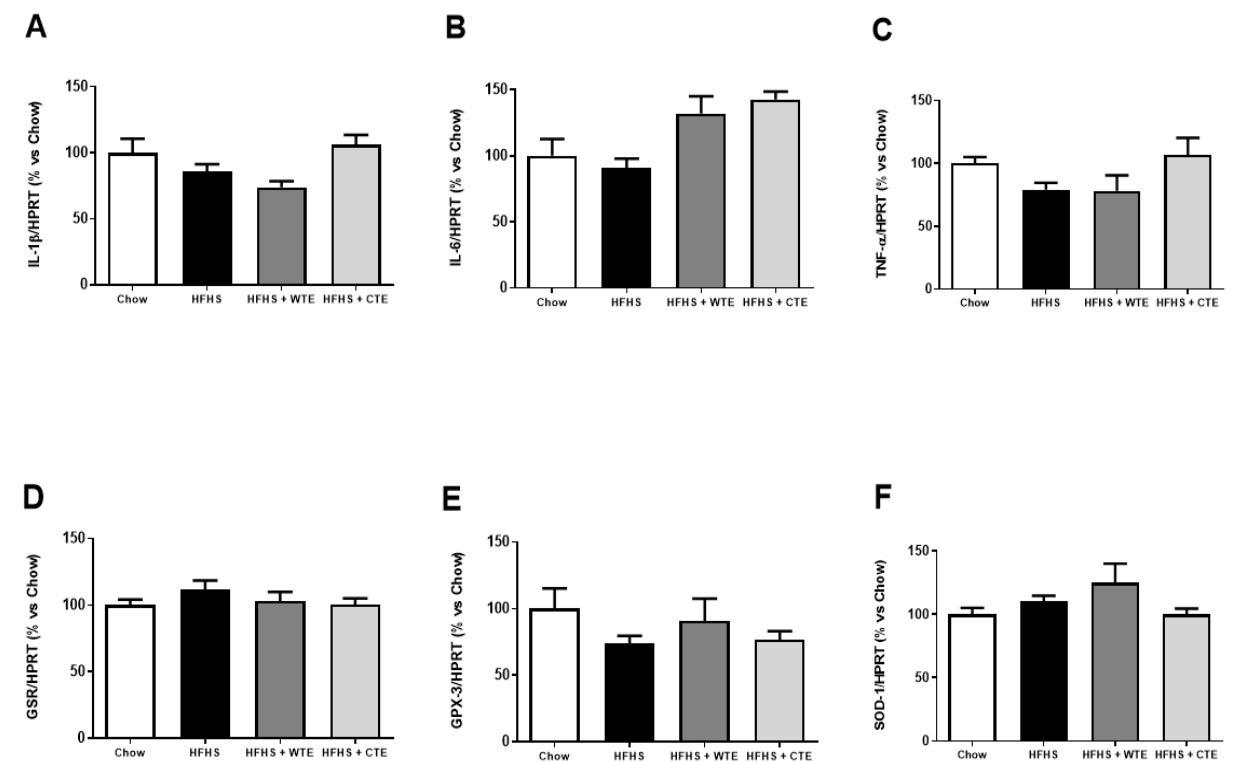
Figure 3. Gene expression of interleukin-1 beta (IL-1 β ) ( A ), interleukin-6 (IL-6) ( B ), tumor necrosis factor α (TNF- α ) ( C ), glutathione reductase (GSR) ( D ), glutathione peroxidase 3 (GPX 3 ) ( E ) and superoxide dismutase-1 (SOD-1) ( F ) in heart tissue after coronary ischemia-reperfusion from mice fed a standard diet (Chow), a high-fat diet/sucrose diet (HFHS), a high-fat diet/sucrose diet supplemented with White Tea Extract (HFHS + WTE), or high-fat diet/sucrose diet supplemented with Tea Complex Extract (HFHS + TCE). The values are represented as the mean ± S.E.M (n = 7–10 samples/experimental group), and expressed as a percentage vs. chow.